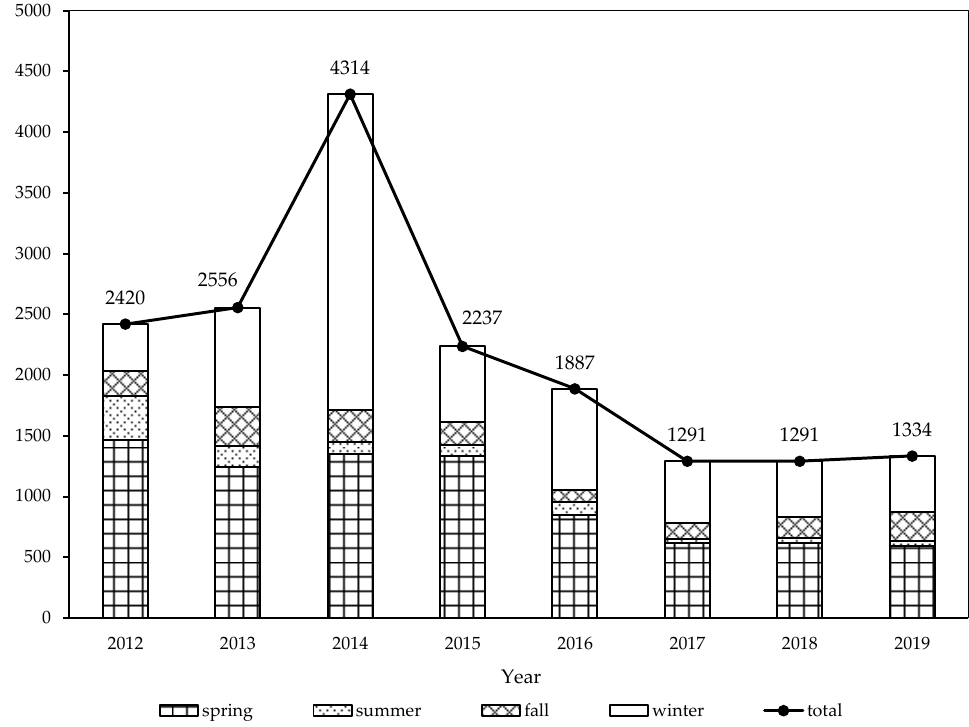
Figure 5. Annual and quarterly changes in high-confidence FFs.